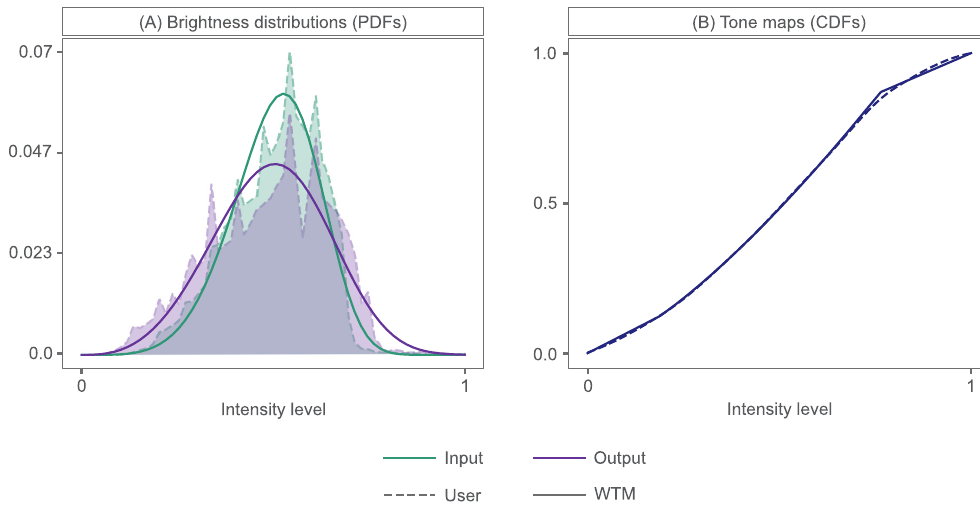
Figure 7. WTM method showing ( A ) WTM proxies of an Input and Output (user-adjusted) brightness PDF and ( B ) the corresponding tone maps that transform PDFs from Input to Output. Dashed and smooth lines depict User and WTM respectively.